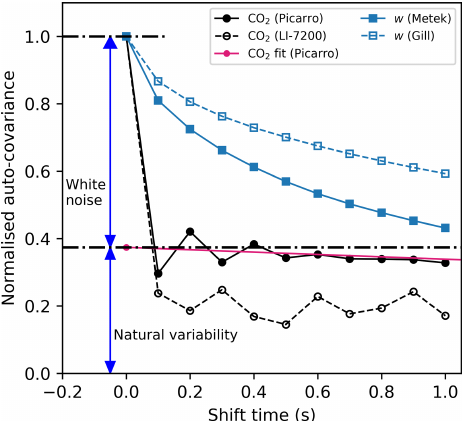
Figure 3. Mean normalised auto-covariance functions of CO 2 and vertical wind velocity ( w ) by four different instruments. The ma- genta line represents a fit to the noise-free auto-covariance function of CO 2 (measured by Picarro) extrapolated back to a zero time shift. An example of the white noise and natural variability contributions to the total CO 2 (measured by Picarro) variance is indicated by two blue arrows. The sharp decrease of the CO 2 auto-covariance be- tween the zero shift and the initial 0.1s shift corresponds to the large contribution of white noise from the gas analysers. The LI-7200 is the noisier instrument. The noise contributions from the anemome- ter are relatively small ( <